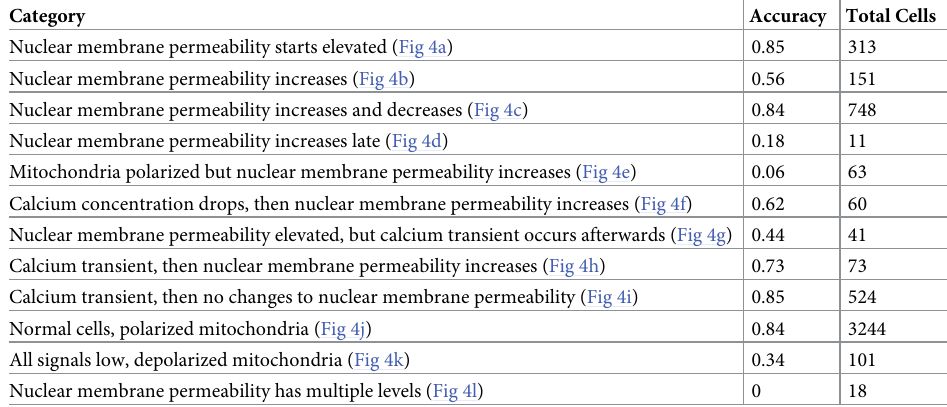
Table 1. Category based accuracy of decision tree